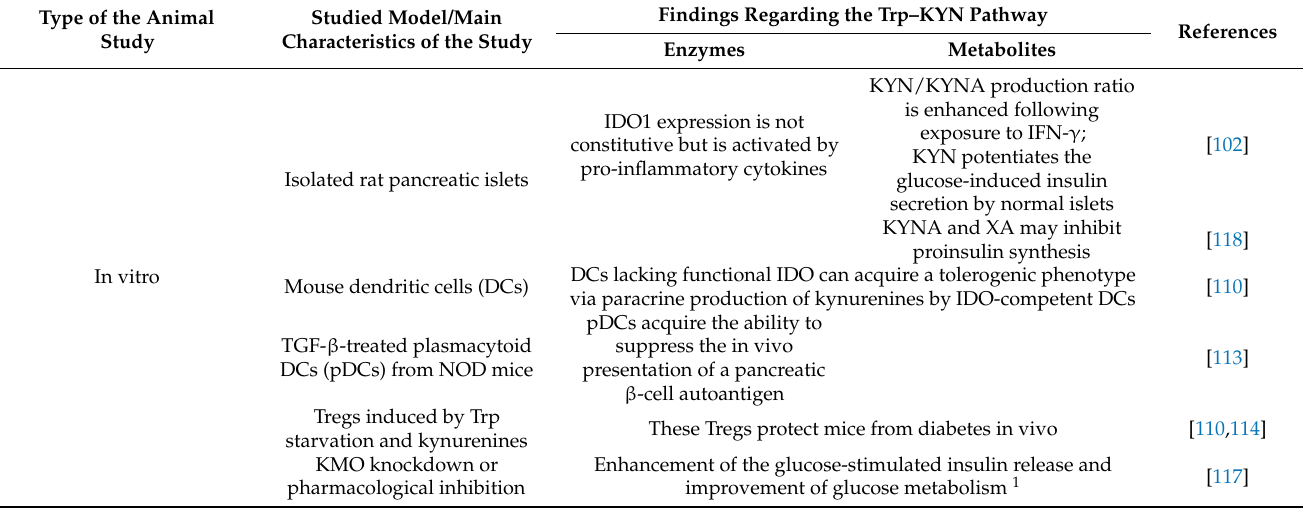
Table 2. Changes in enzymes and metabolites of Trp–KYN pathway in diabetes mellitus.